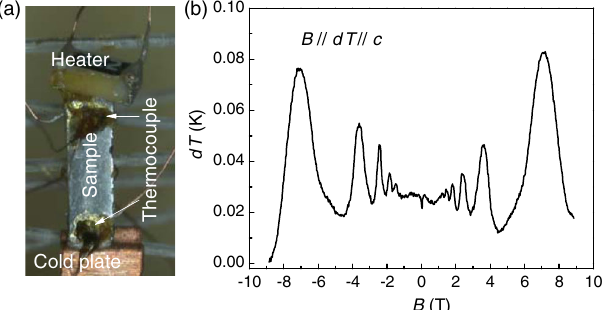
FIG. 1. Thermal conductivity measurement configuration and raw experimental data of temperature gradient dT ð B Þ . (a) TaAs sample (TAc) mounted onto a copper cold plate. A chip resistor of 2000 Ω is used as a heater and a thin ( ϕ ¼ 25 μ m) chromel − AuFe 0 thermocouple for detecting dT . Manganin wires . 07 % ( ϕ ¼ 25 μ m) used for simultaneous electrical resistivity mea- surements are connected to the back side of the sample by spot welding. See Sec. VI for more details on the thermal transport measurements. (b) Raw experimental values of dT recorded in a continuous field scan between B ¼ − 9 and 9 T at T ¼ 2 K, with a fixed heating power. Both the heat current and magnetic field are applied along the c